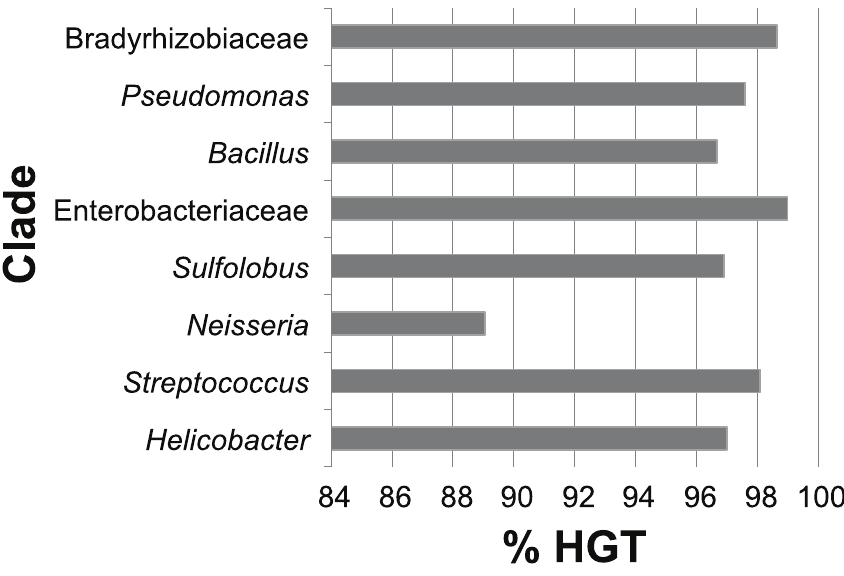
Figure 2. Relative contribution of horizontal gene transfer in protein family expansions.